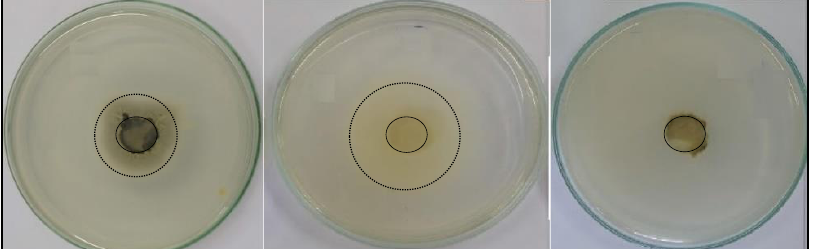
Figure 4. Halos of the growth of Aspergillus niger , Cladosporium cladosporioides , and Penicillium fellutanum (from left to right) in potato dextrose agar (PDA) medium supplemented with biosurfactant- complexed silver nanoparticles (BS-AgNP) at a concentration of 16.50 µg/L. The agar plugs are highlighted in the image by a solid line, while the halo of mycelium growth is represented by dashed lines.